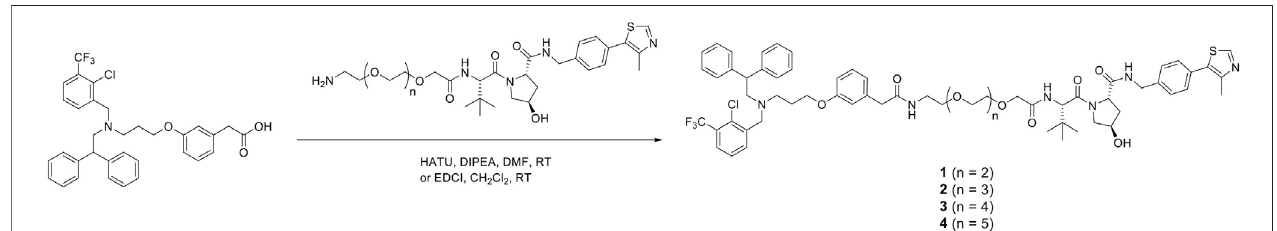
SCHEME 1 | Synthesis of PROTACs for LXR (GW3965-PEG-VH032, 1 – 4 ).